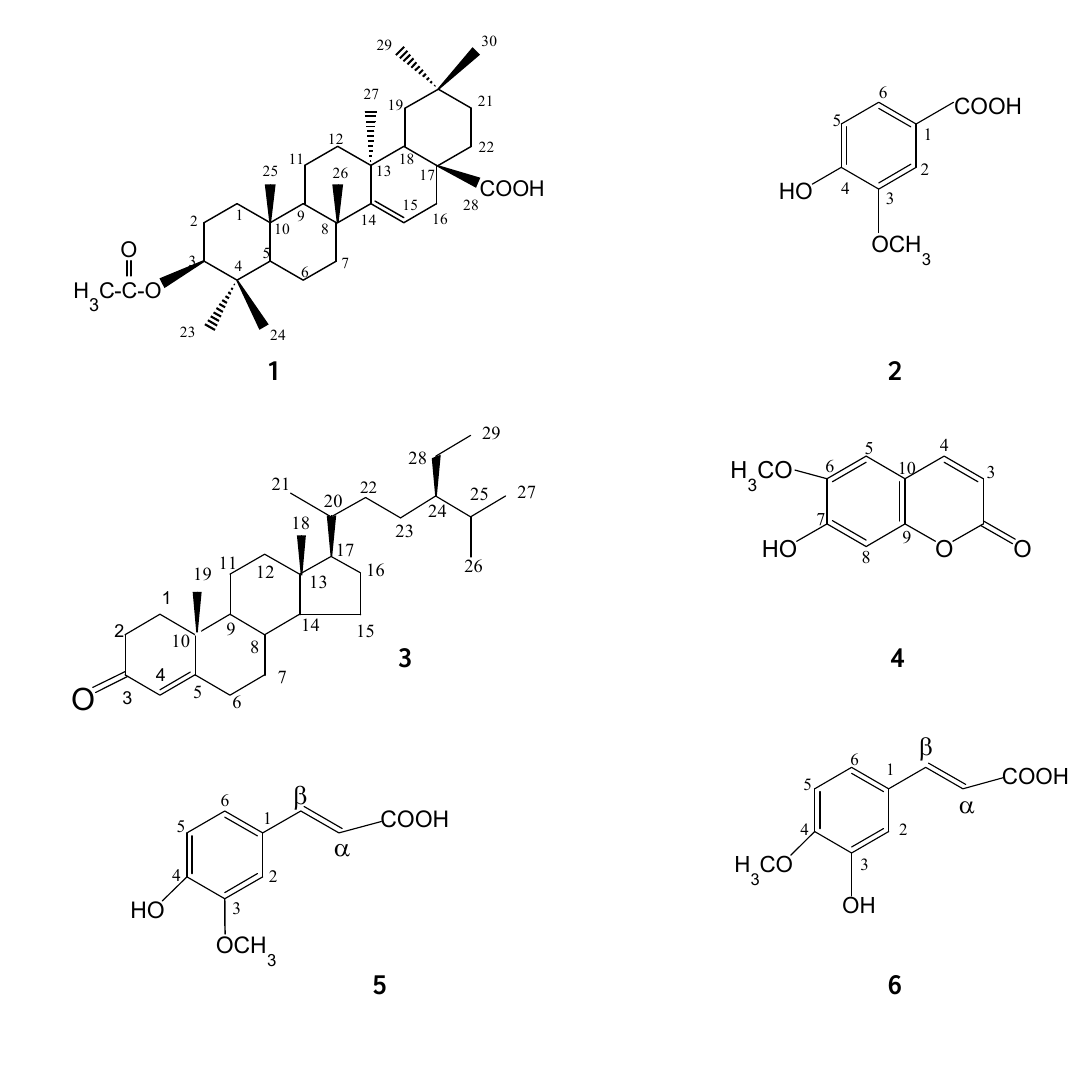
Figure 1. Structures of compounds 1 – 6